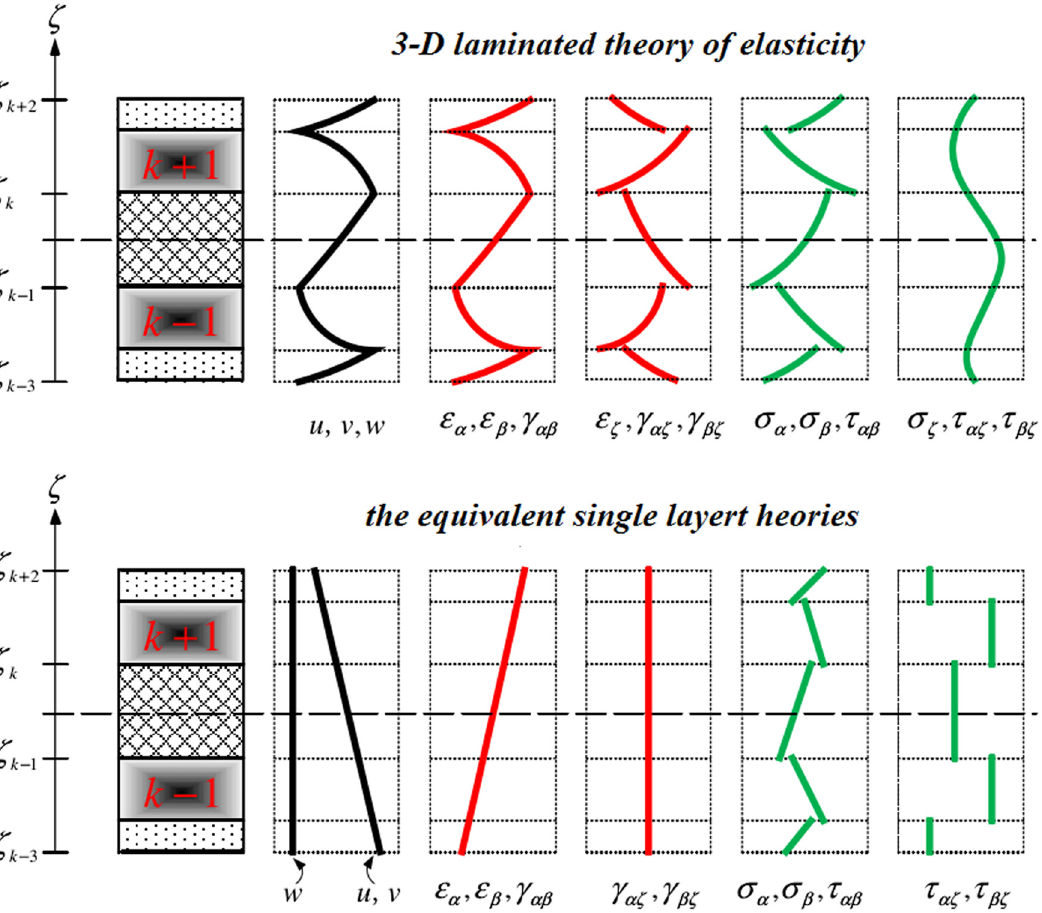
Figure 3: Distributions of displacements, strains, and stresses along ζ of the ESL theories and 3 - D laminated theory of elasticity [ 77 ]